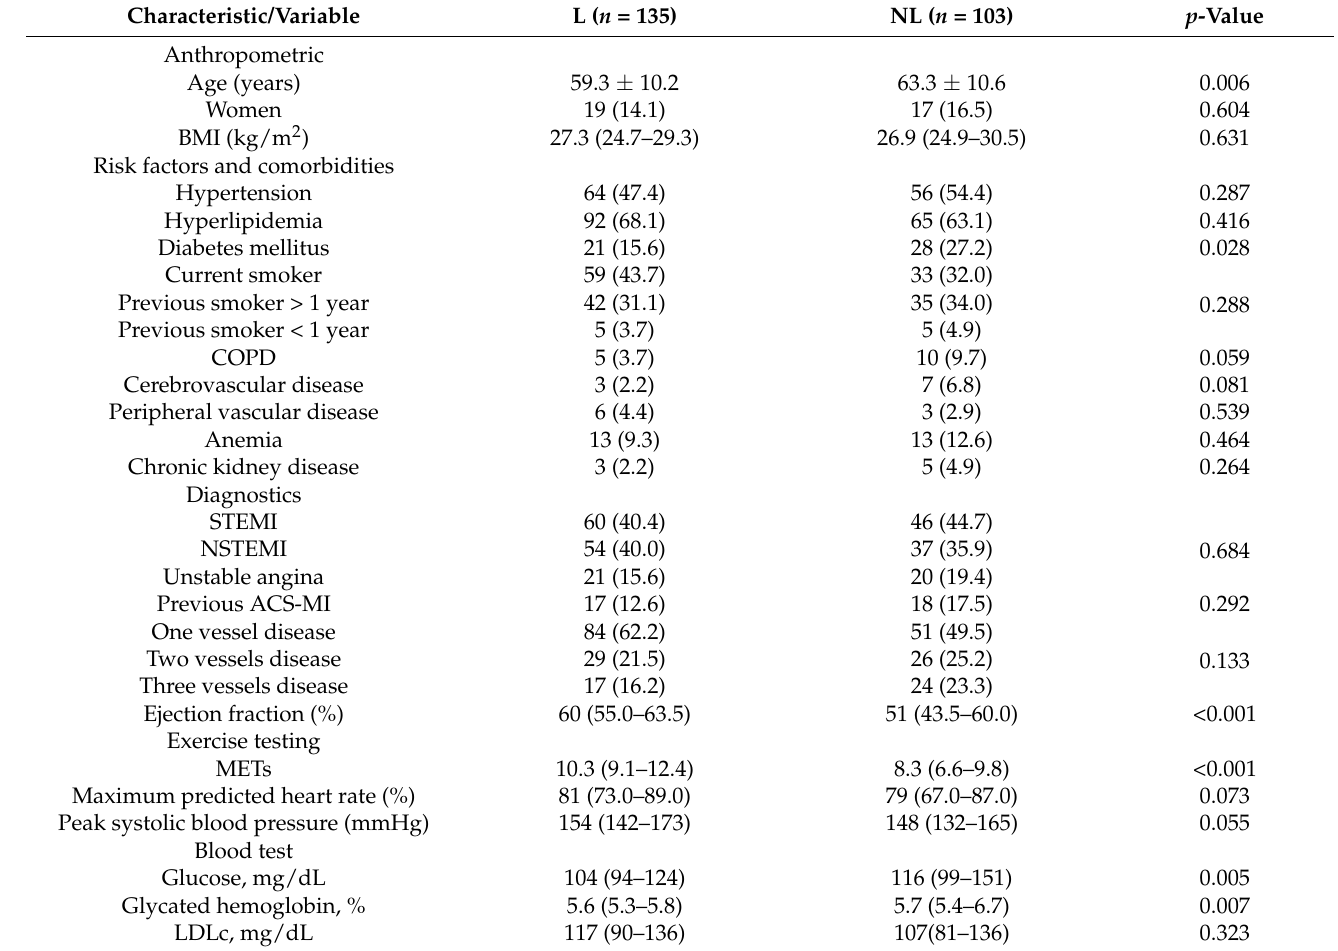
Table 1. Baseline characteristics according to the low and no-low groups.